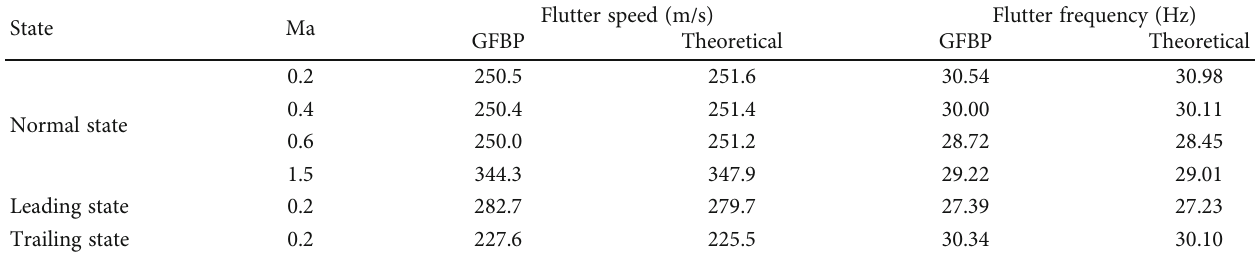
Table 2: Comparison of GFBP results and theoretical results for the three